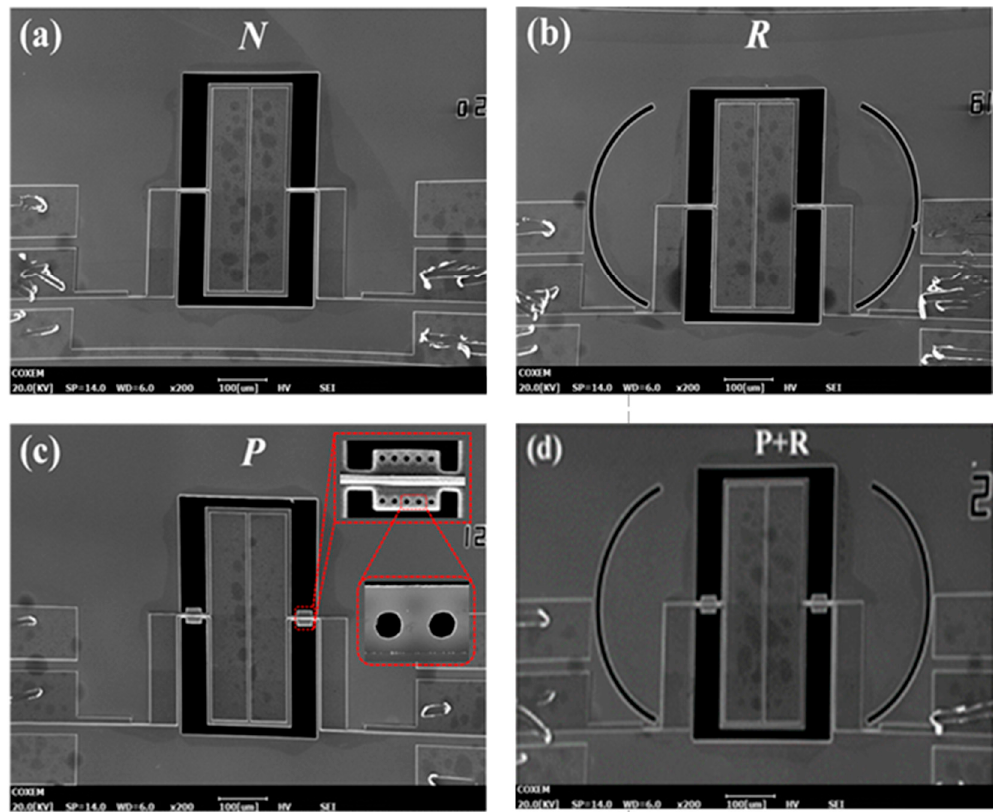
Figure 6. SEM photo of TPoS resonator. ( a ) Conventional structure; ( b ) Resonator with quarter wavelength reflector structure; ( c ) Resonator with 1D-PnC on the supporting tether ( d ) Resonator with 1D PnC-Reflector Composite Structure.